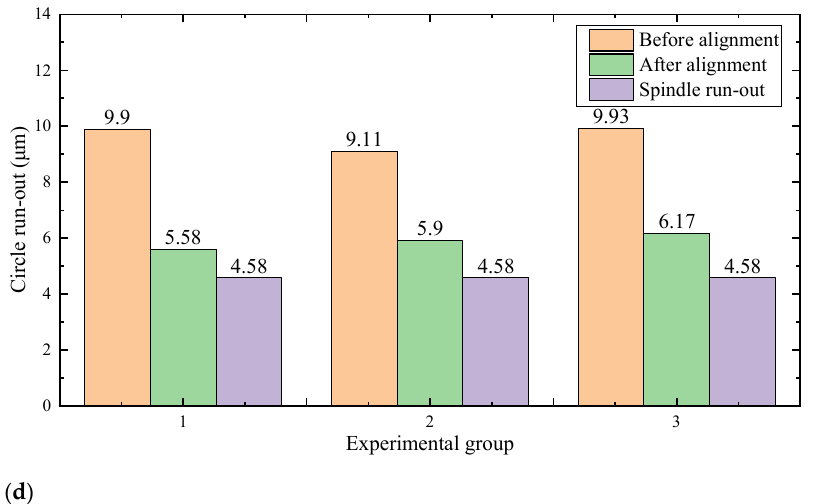
Figure 7. Experimental results. ( a ) Results of the first self-aligning experiment. ( b ) Results of the second self-aligning experiment. ( c ) Results of the third self-aligning experiment. ( d ) Comparison chart of the three experimental results.